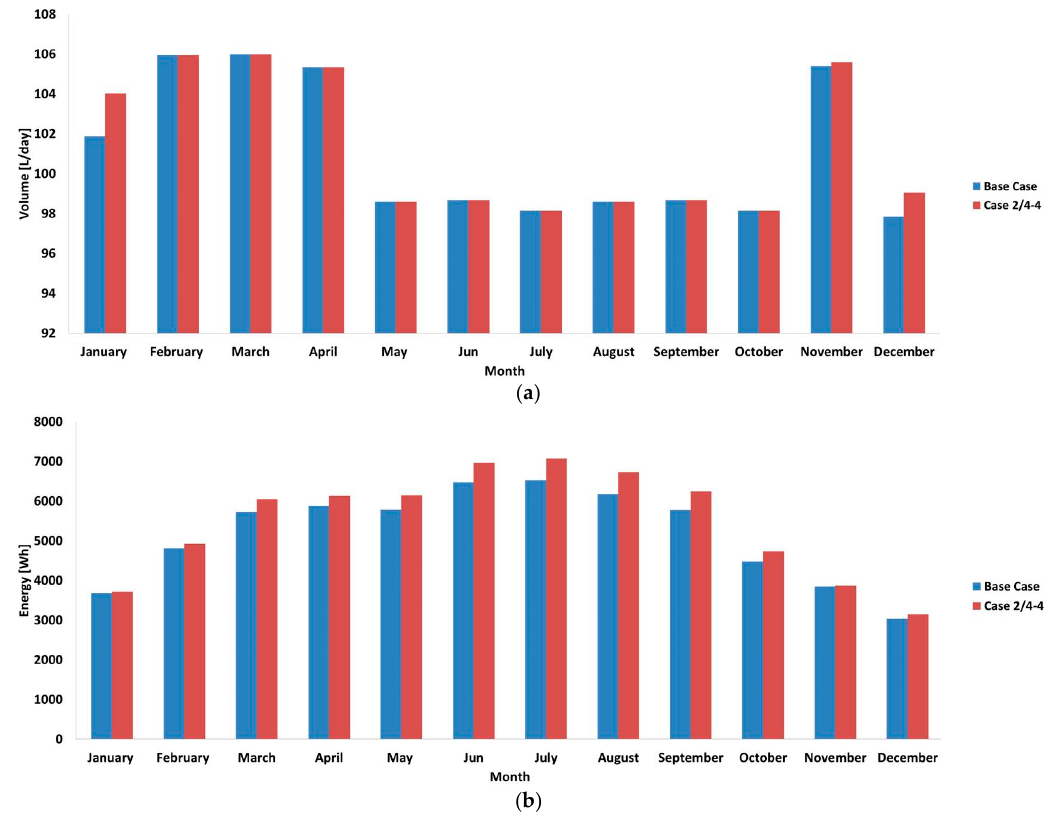
Figure 14. SHW ( a ) and electricity ( b ) average production per month. Table 11. MD non-operational days.